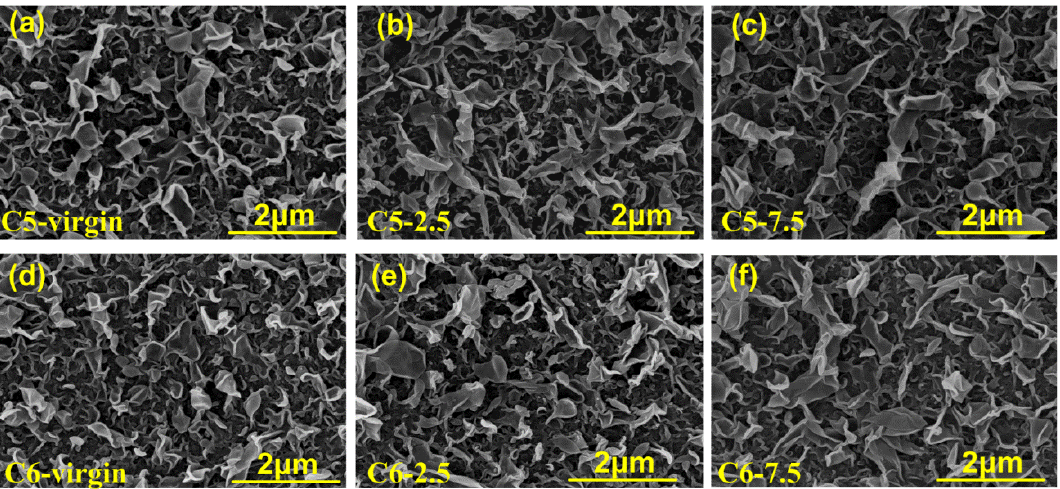
Figure 6. Surface SEM images of RO membranes: ( a , d ) prior to exposure and ( b , c , e , f ) after 6 months of exposure to the acid solutions.